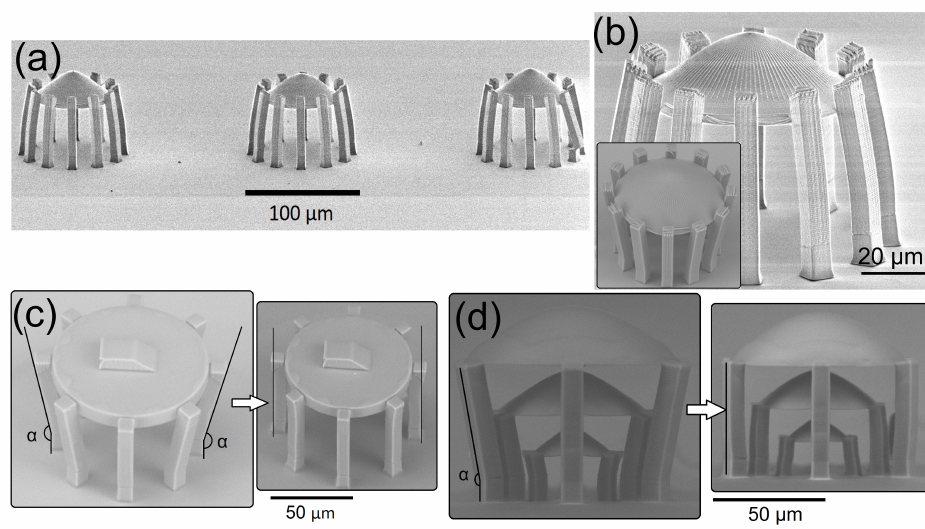
Figure 5. Scanning electron micrographs of a few benchmarking micro-optical components validating the feasibility of the proposed method for the manufacturing of assembled devices: ( a )—a row of suspended calcinated free-standing aspheric micro-lenses; ( b ) closeup of single micro-lens indicating fine features, i.e., periodical grating on the lens surface remains undistorted after heat-treatment, inset—the same lens before calcination; ( c ) microprism on a pedestal with pre-compensated angle α = 11 ◦ for calcination; ( d )—a compound micro-optical component consisting of three stacked micro- lenses. Micrographs ( c , d ) are size-adjusted to show the structures dimensions before ( left ) and after ( right ) calcination on the same scale. All of the shown demonstrators prove the final free-form geometries are achievable via shrinkage dimensional pre-compensation in pristine material and perfectly arranged architectures after